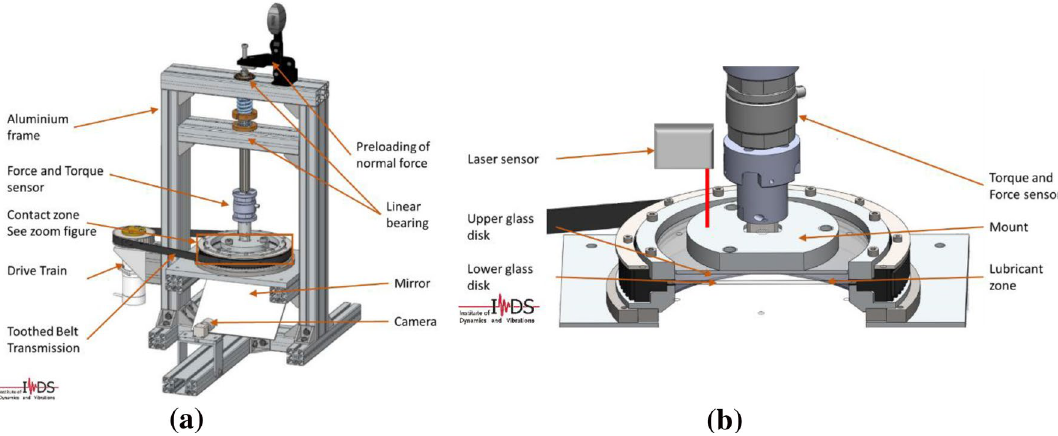
Fig. 2 WDI test rig: a overview, b detail of the contact section [22]